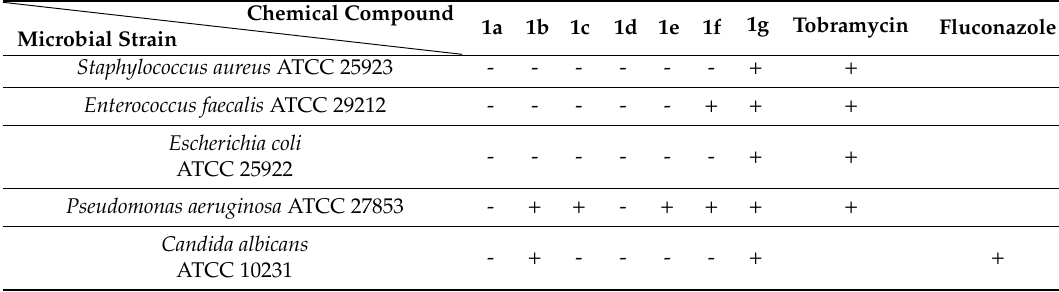
Table 4. The qualitative antimicrobial activity evaluation of the new compounds. Microbial Strain